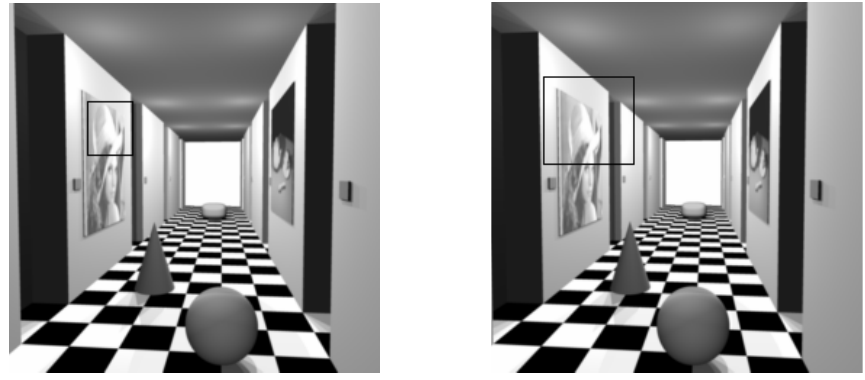
Figure 1 : Stereo image pair with left image with template window and right image with search